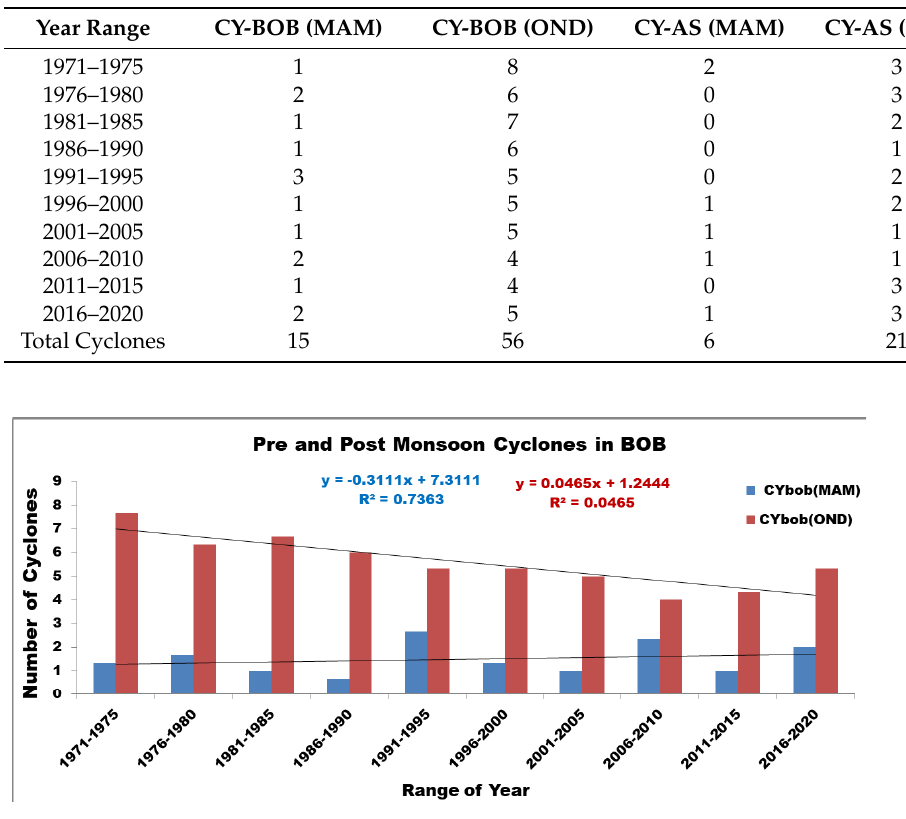
Figure 7. Comparison of pre −monsoon and post − monsoon cyclone frequencies in BOB.